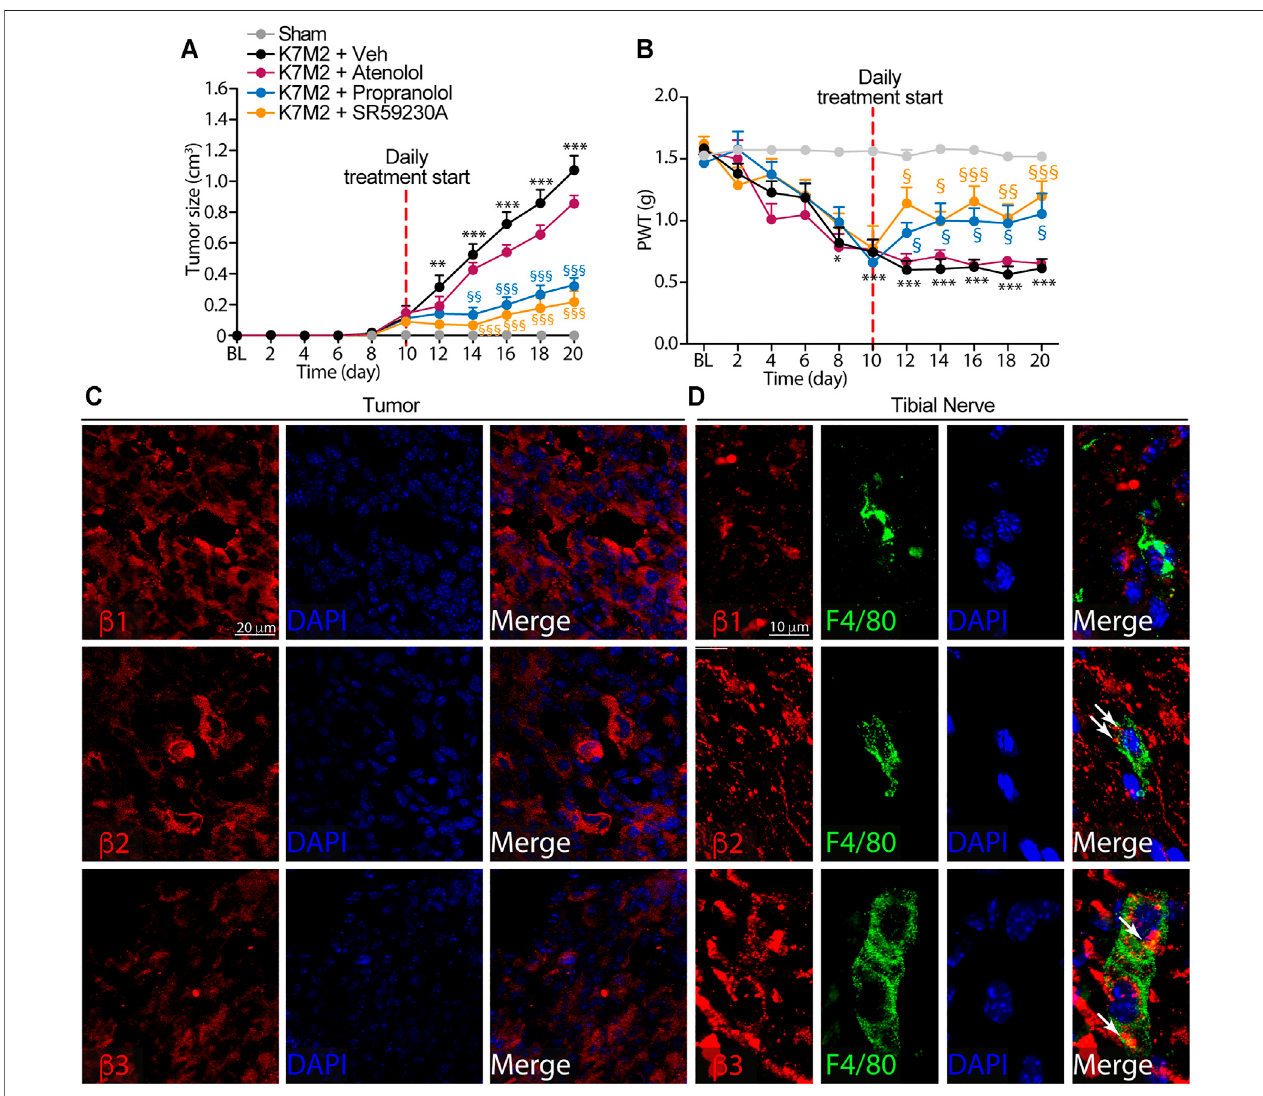
FIGURE2| β 2-and β 3-,butnot β 1-ARsantagonismreduceK7M2osteosarcomagrowthandmechanicalallodyniainBALB/cmice (A) Timedependentincreasein tumor size and (B) mechanical allodynia after para-tibial K7M2 osteosarcoma cell inoculation or sham in BALB/c mice treated (daily, starting from day 10) with atenolol (10 mg/kg, i.p.), propranolol (10 mg/kg, i.p.), SR59230A (10 mg/kg, i.p.), or vehicle (Veh) (C and D) Representative immuno fl uorescence images of β 1-, β 2-and β 3-ARs expression in (C) tumor cells and (D) macrophages (F4/80 + cells) in tibial nerve, 20 days after para-tibial inoculation of K7M2 osteosarcoma cells. BL, baseline. PWT, paw withdrawal threshold. N (cid:2) 6 mice.** p < 0.01, *** p < 0.001 vs Sham; § p < 0.05, §§ p < 0.01, §§§ p < 0.001vs K7M2 + Veh. Dataare presented asmean ± SEM. Two-way ANOVA and Bonferroni post hoc test.